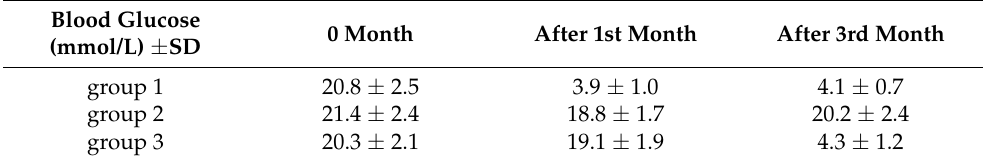
Figure 1. Study design showing the three groups of BB/OKL (bio breeding/ OKL , Ottawa Karlsburg Leipzig) rats with different insulin therapy over 3 months and the performed analyses. Male ( n = 38), 2-month old, BB/OKL rats were randomized into three groups receiving insulin treatment by implanted subcutaneous osmotic insulin pumps. Group 1 animals received 2U of insulin and group 2 animals 1U of insulin per 24 h for 3 months. Group 3 animals received 1U per 24 h in the first month, followed by 2U per 24 h in the second and third month. mNCV = motor nerve conduction velocity, csNCV = combined sensorimotor nerve conduction velocity, U = unit, TIND = treatment-induced neuropathy in diabetes. Table 1. Mean blood glucose concentrations in the three experimental groups of rats. Data from group 1, n = 12; group 2, n = 10; group 3, n = 16 are presented as means ± SD. Blood Glucose